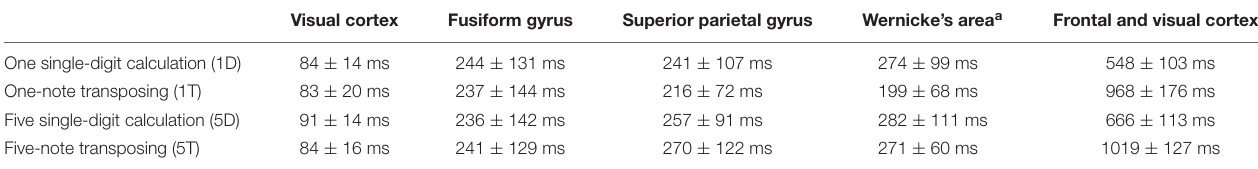
FIGURE 3 | Sample results of the MEG recordings (MR-FOCUSS analyses) showing simultaneous frontal and occipital activation at 513 ms latency in five single-digit calculation (5D) for the same participant shown in Figure 2 . TABLE 1 | Temporal resolution of magnetoencephalography (MEG) signals arising from the peak brain activation during each task Visual cortex Fusiform gyrus Superior parietal gyrus Wernicke’s area a Frontal and visual cortex b